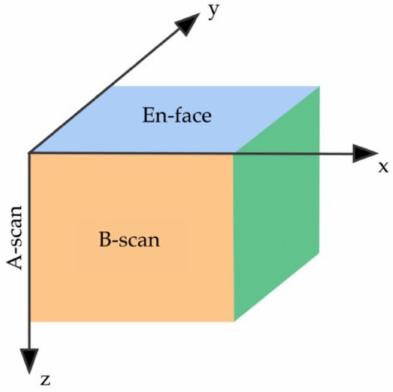
Figure 1. Graphical representation of acquired OCT